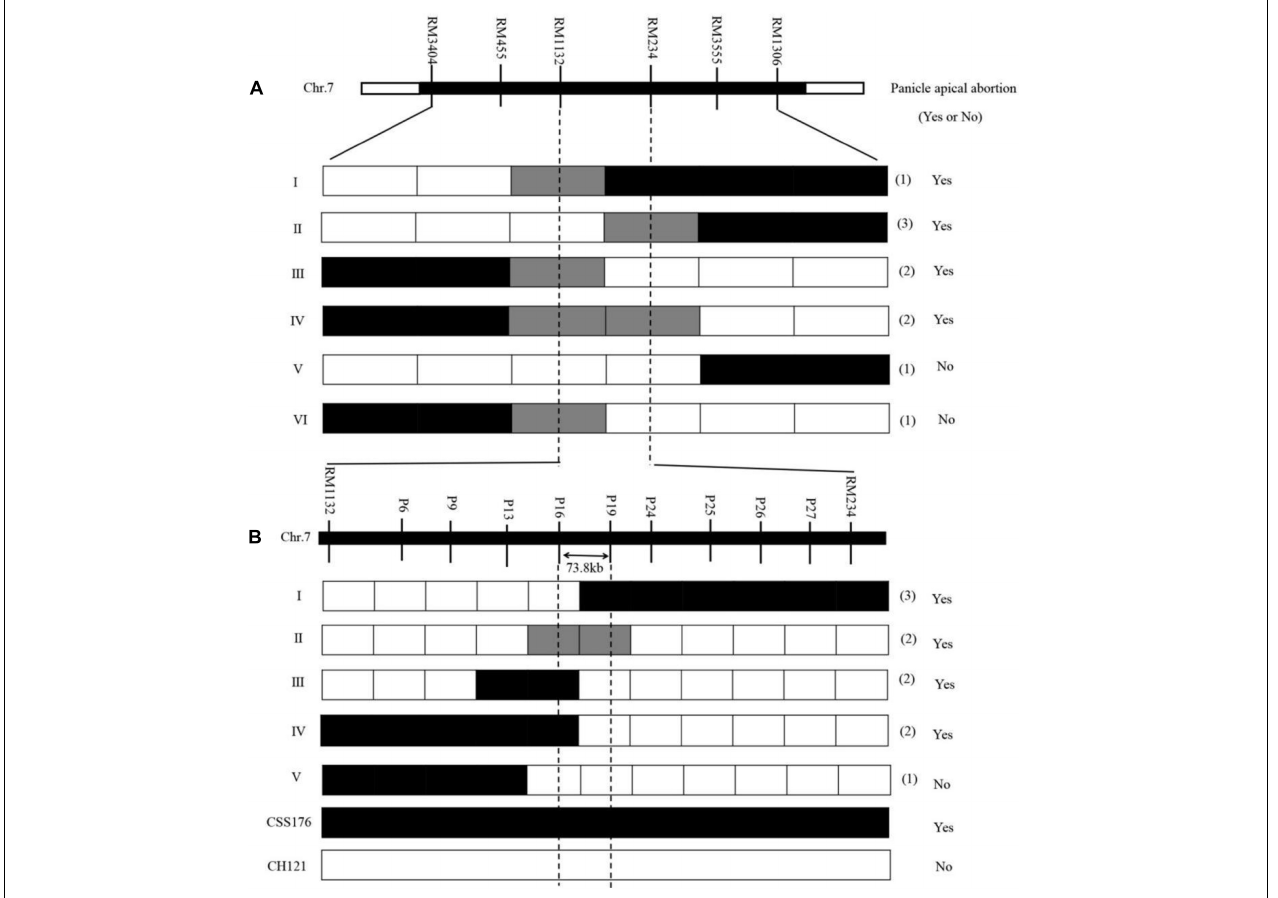
FIGURE 4 | Fine mapping of qPAA7 . (A) Linkage analysis of phenotypes and marker genotypes between RM1132 and RM234. (B) Linkage analysis of phenotypes and marker genotypes between P16 and P19. Panicle apical abortion (Yes or No), represents the panicle apical abortion, and no panicle apical abortion, respectively.